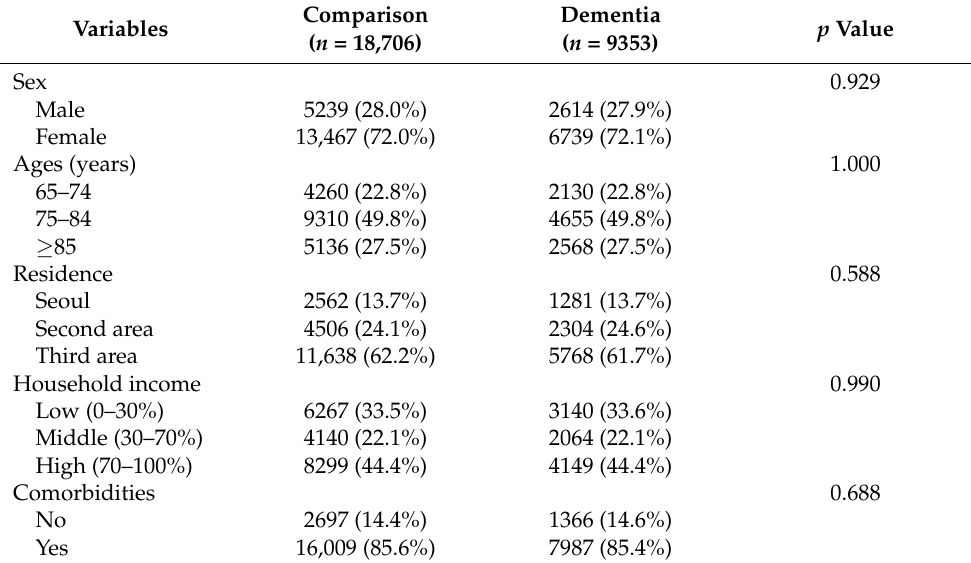
Table A2. Detailed characteristics of the dataset for